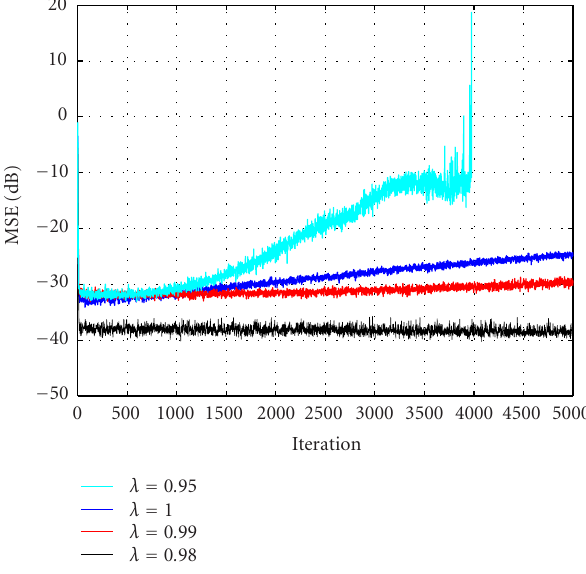
Figure 6: A posteriori error-feedback algorithm for λ = 1,0 . 99, 0 . 98, and 0 .